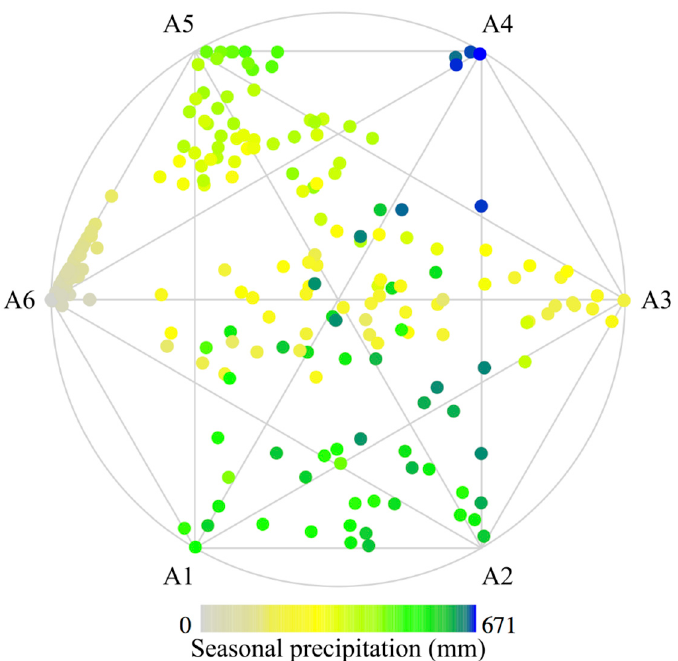
Figure 3. Simplex plot of seasonal precipitation with respect to the decomposed 6 archetypes. The data points are colored by the average observed precipitation over the whole Yangtze River Basin. The archetypes at the corners represent the extremal patterns, and are notated as A k for the k -th archetypal pattern.